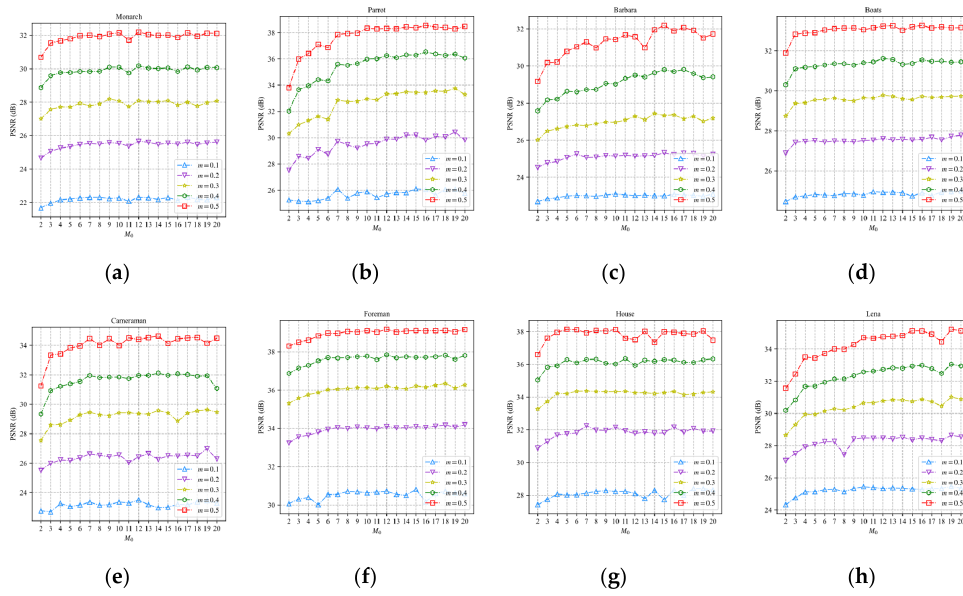
Figure 12. PSNR curves of eight test images: ( a ) Monarch; ( b ) Parrot; ( c ) Barbara; ( d ) Boats; ( e ) Cam- eraman; ( f ) Foreman; ( g ) House; ( h ) Lena.